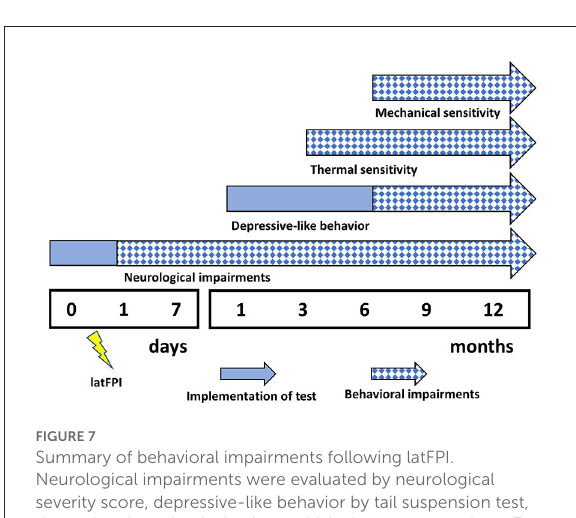
FIGURE7 Summary of behavioral impairments following latFPI. Neurological impairments were evaluated by neurological severity score, depressive-like behavior by tail suspension test, thermal and mechanical pain sensitivity by acetone and von Frey test,